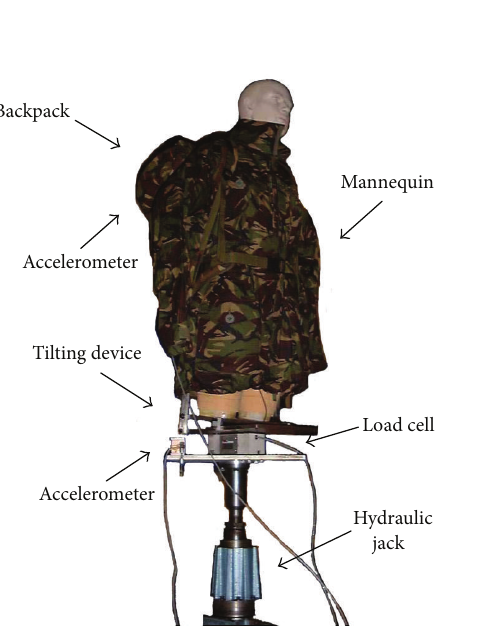
Figure 2: The human-pack interaction force 󳨀⇀ 𝑀 moment 𝑝 acting at the pack mass centre, and the associated 󳨀⇀ 󳨀⇀ 𝑀 𝐹 and acting at the trunk mass centre. reactions pack pack